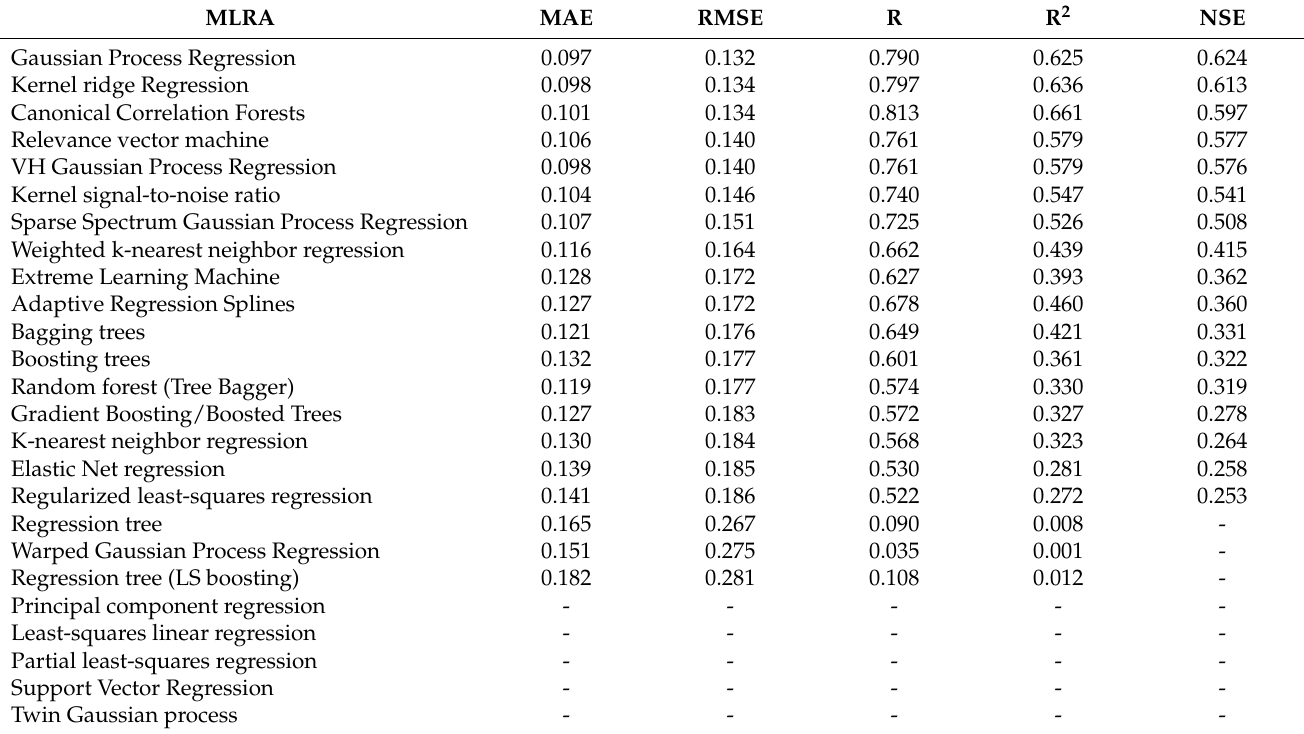
Table 8. Estimation accuracy of the best-performing prediction models of EC Leaf derived from Sentinel-2 spectra. MAE: Mean Absolute Error; RMSE: root-mean-square error; R: coefficient of correlation; R 2 : coefficient of determination; NSE: Nash–Sutcliffe